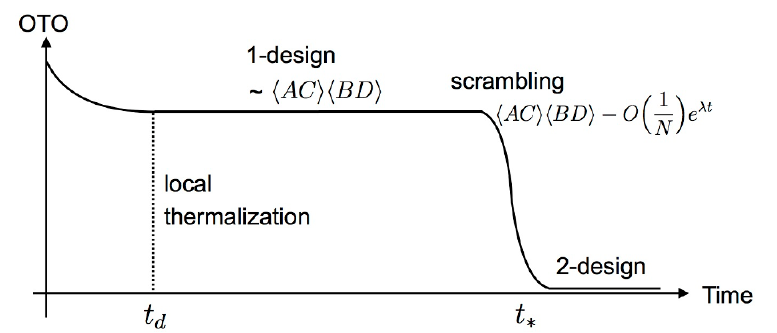
Figure 2 . Thermalization and scrambling in the decay of a four-point OTO correlator. These correlators typically decay to AC BD in a thermal dissipation time t d , and then they decay to h ih i a (cid:13)oor value d (cid:0) 2 at around the scrambling time t (cid:3) . These regimes are very well captured by (cid:24) replacing the dynamics with 1-designs or 2-designs, respectively.